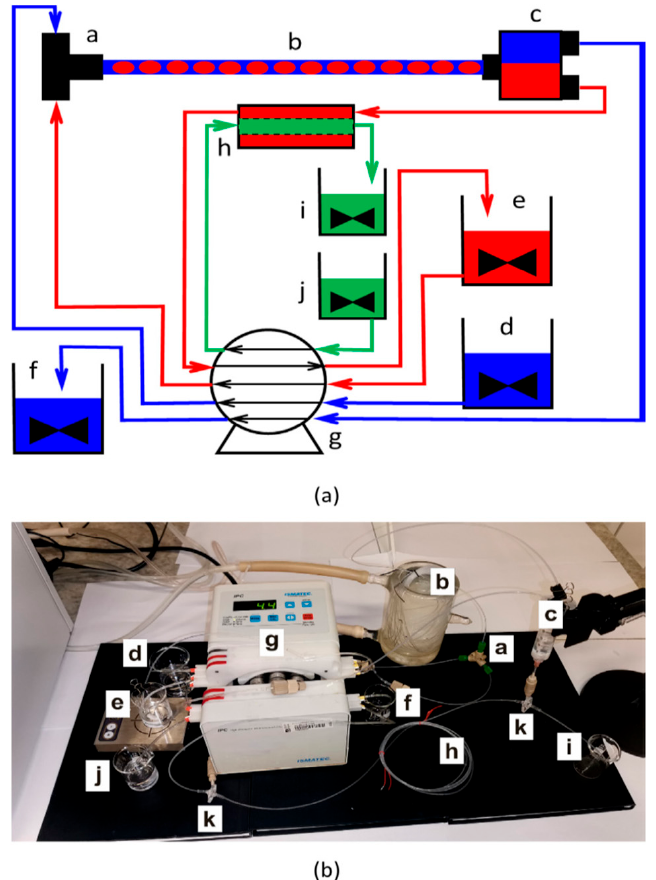
Figure 3. Scheme ( a ) and photo ( b ) of a cephalexin ( 2 ) flow system with enzyme recycling. Reprinted with permission from ref. [83], Copyright 2020 Elsevier B.V.